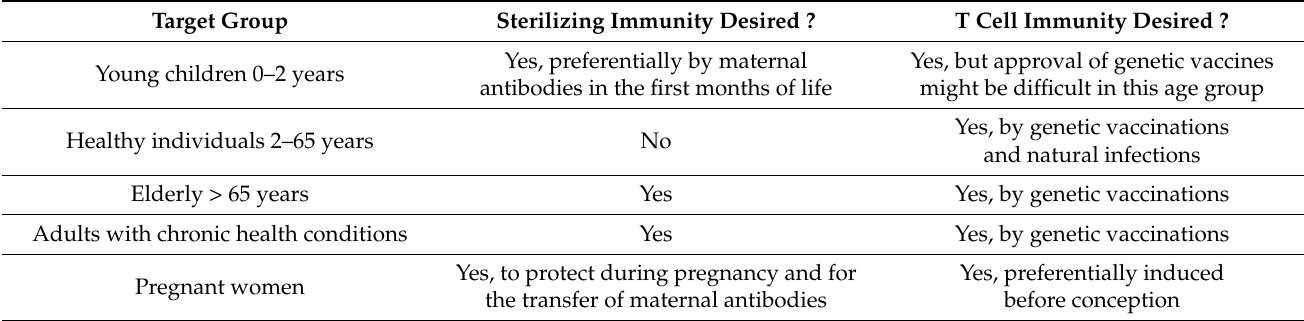
Table 2. Implementation of T cell immunity in vaccination